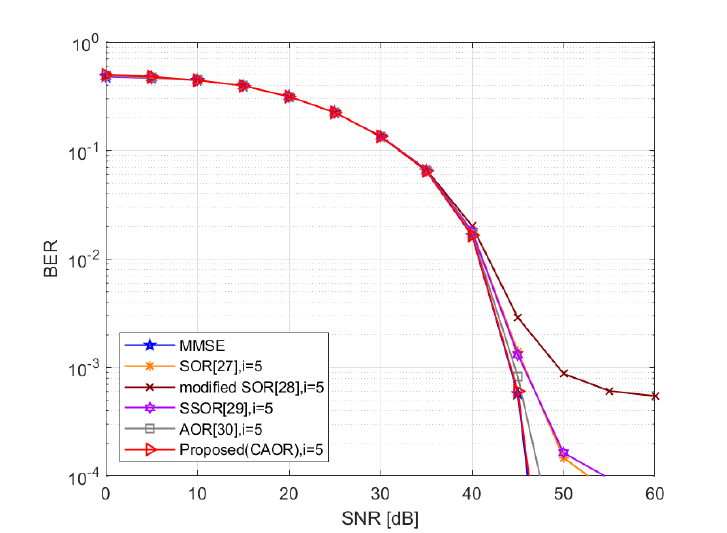
Figure 4. BER performance comparison for different detection schemes, N R × N T = 64 × 16.